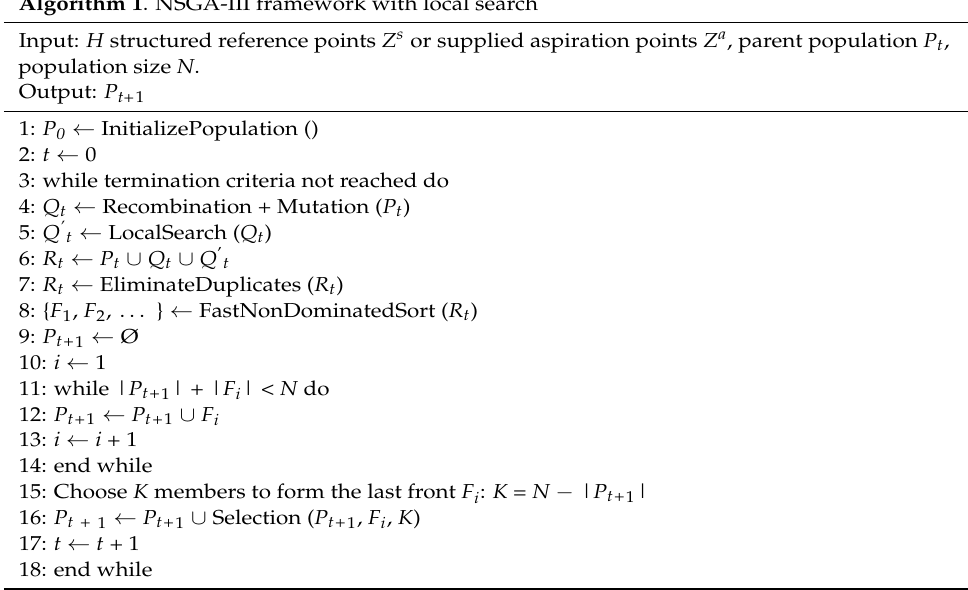
Algorithm 1 . NSGA-III framework with local